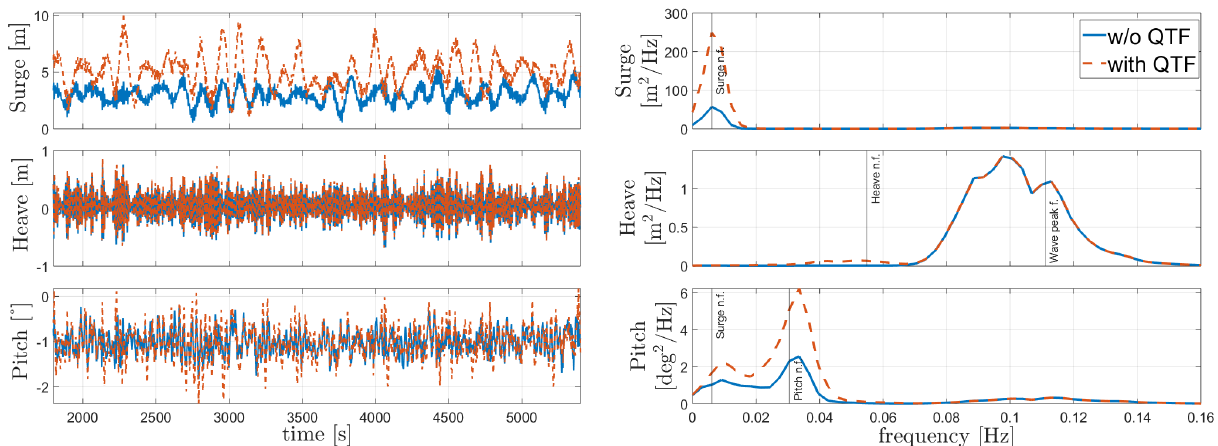
Figure 16. Activefloat response to EWM for 50 years of wind and ESS ( T p = 9s ,H s = 5 . 11m).